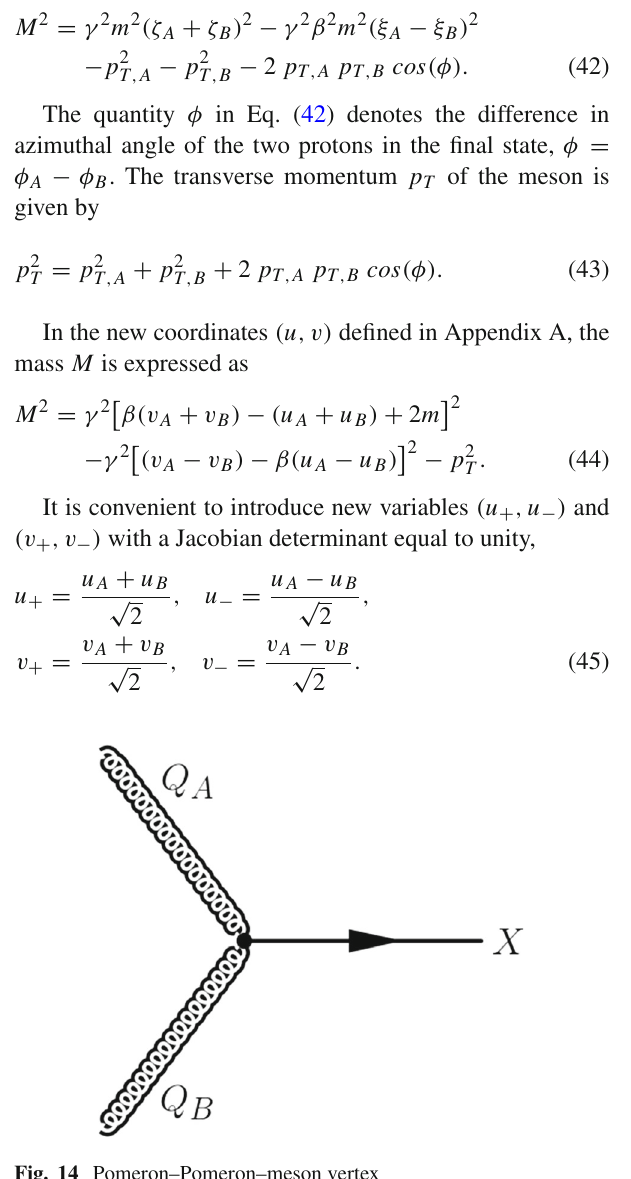
Fig. 13 Proton–Pomeron kinematics in (u,v)-plane Fig. 14 Pomeron–Pomeron–meson